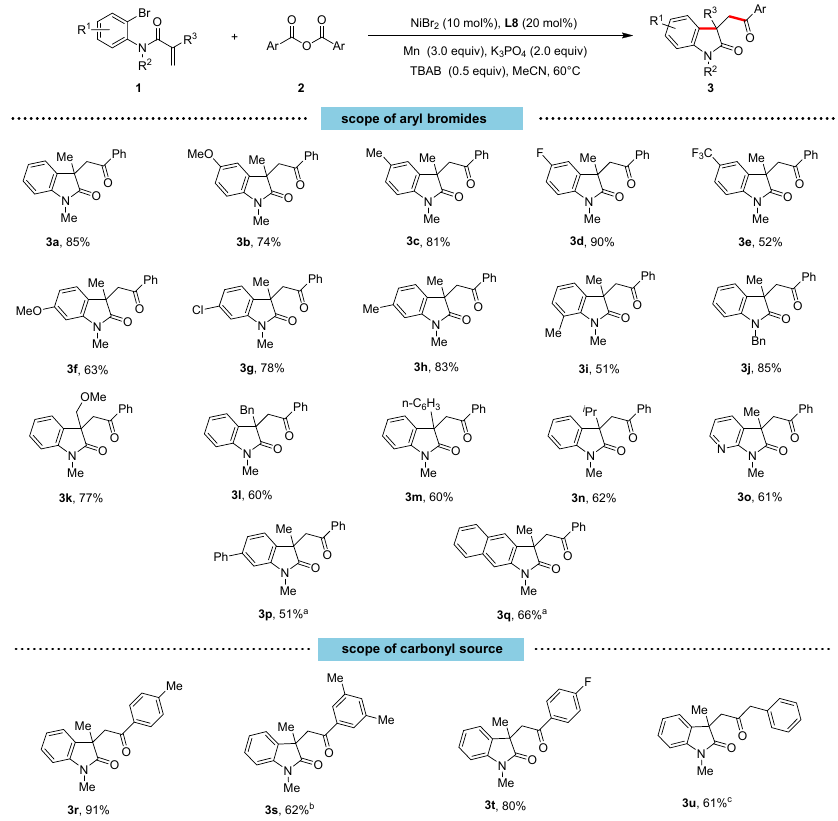
Scheme 2. Ni-catalyzed reductive aryl-acylation of alkenes. a Aryl triflates instead of aryl bromides. b 80 ◦ C. c Reaction conditions: N -(2-iodophenyl)- N -methylmethacrylamide (0.10 mmol),